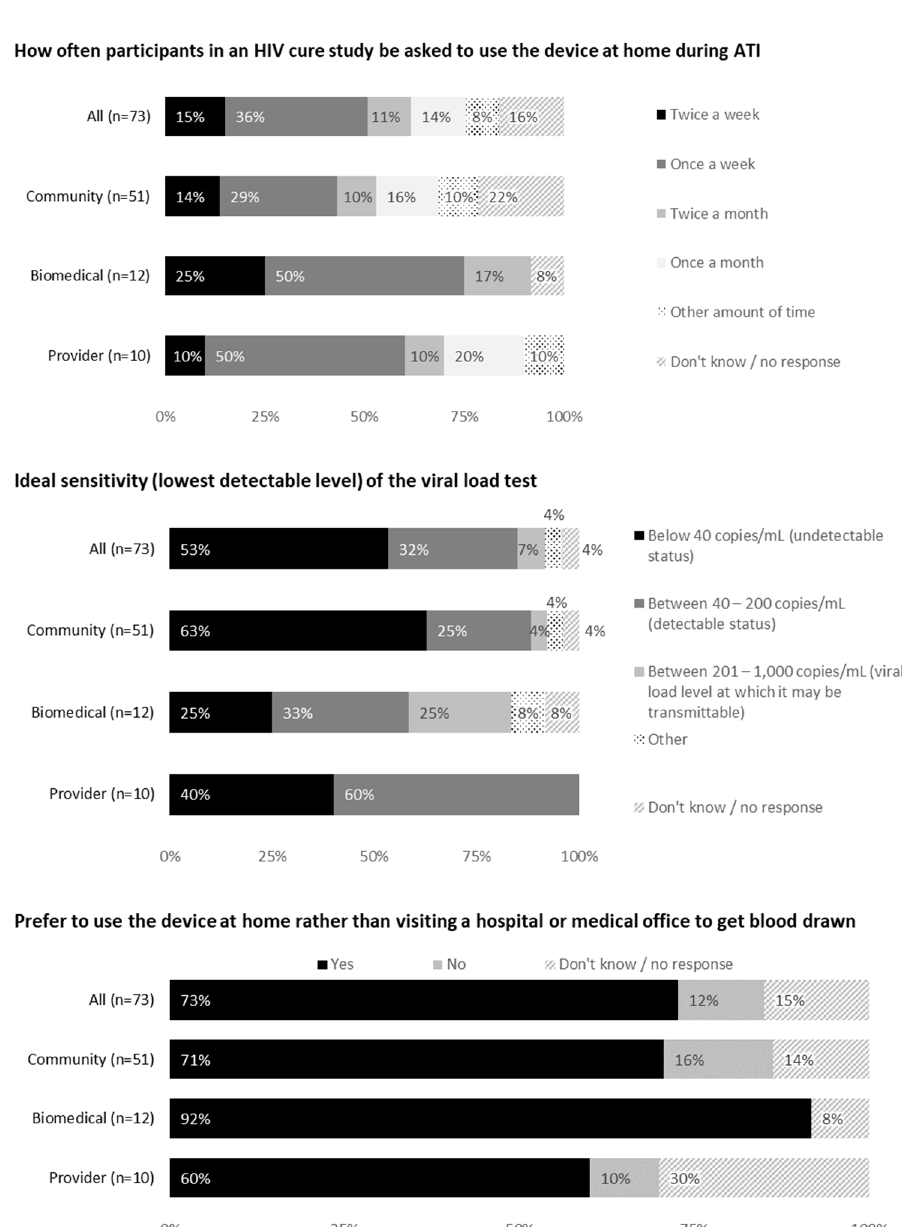
Figure 2. Feedback on use of the device from all participants (United States, 2021).